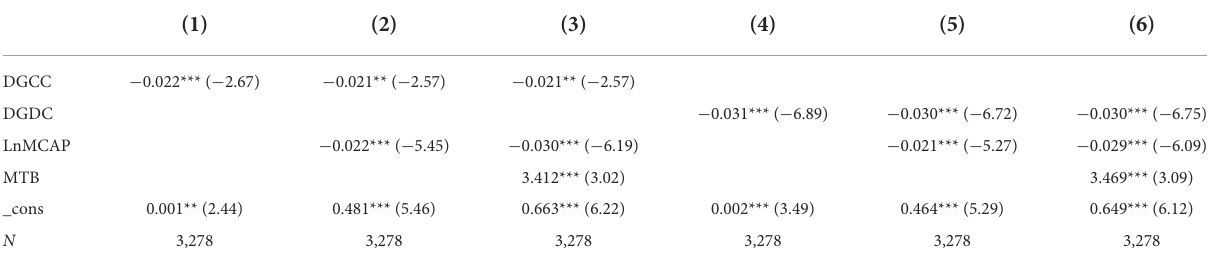
TABLE 3 Panel regression.